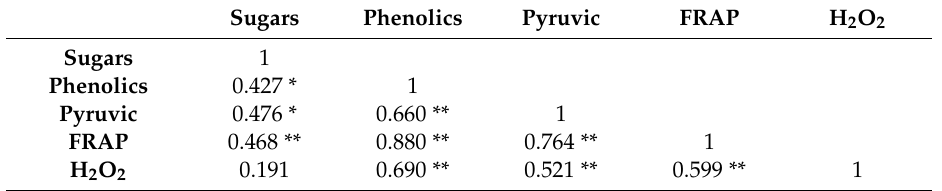
Table 5. Correlation table of garlic polar ingredients and antioxidant properties of the 34